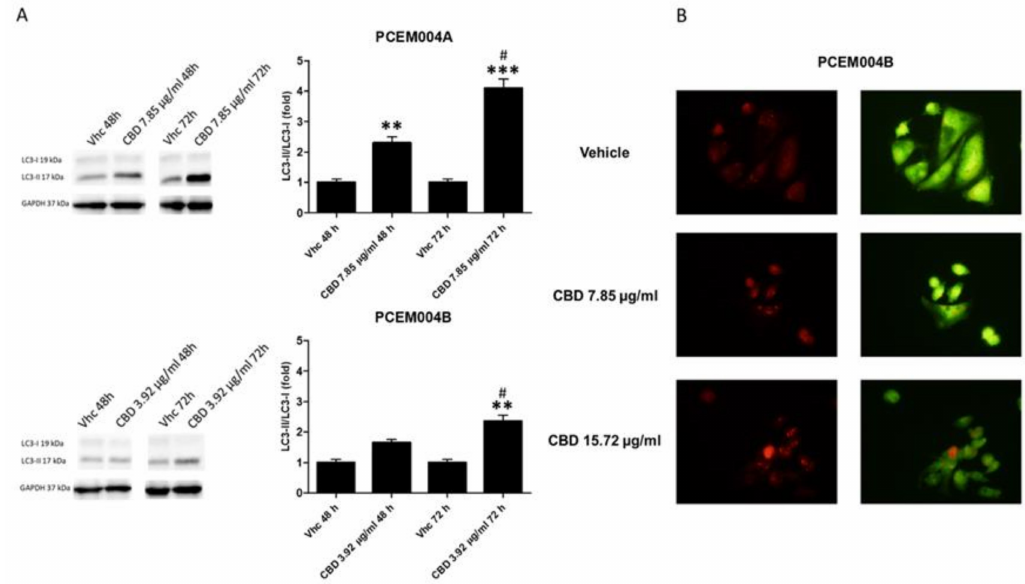
Figure 11. CBD induced autophagy in mixed type I / II EC cell lines. ( A ) Western blot analysis and densitometric quantification of LC3 protein levels PCEM004a and PCEM004b mixed type EC cell lines treated for up to 72 h with CBD 7.85 µ g / mL and 3.92 µ g / mL, respectively. Densitometric values, shown as the mean ± SD, were normalized to GAPDH used as loading control. Blots are representative of one of three separate experiments, ** p < 0.01, *** p < 0.001 treated vs. untreated cells, # p < 0.05 72 h vs. 48 h of treatment. ( B ) Representative image of PCEM004a treated with CBD up to 7.85 µ g / mL for 48 h and stained with acridine